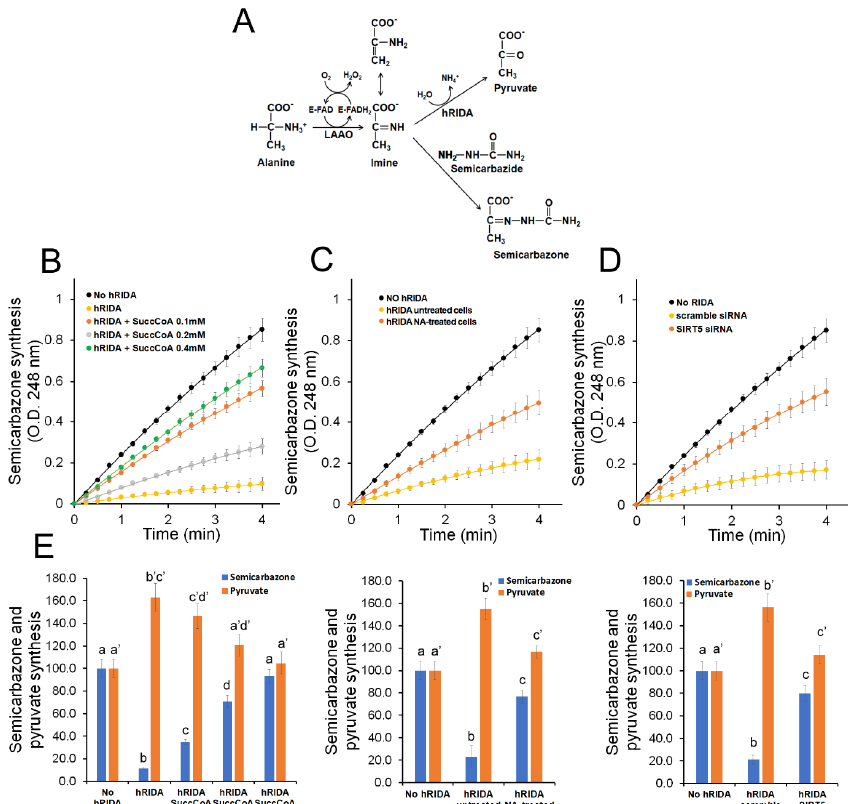
Figure 5. K-succinylation of hRIDA caused a strong reduction of hRIDA deaminase activity. ( A ) Reaction scheme of oxidative deamination of L-amino acids to the corresponding keto-acid catalyzed by the flavoprotein L-Amino Acid Oxidase (LAAO), through the formation of an unstable α -imino acid intermediate. The oxidative deamination of L-alanine generates the toxic compound 2-aminoacrylate (2AA) that tautomerizes to 2-iminopropionate (iminopyruvate), which is hydrolyzed to pyruvate and ammonia, spontaneously or enzymatically by hRIDA. The α -imino acid (iminopyruvate) intermediate reacts with semicarbazide to form the corresponding semicarbazone, which can be determined spectrophotometrically. ( B ) Time course of semicarbazone synthesis reactions carried out in the absence (no hRIDA) or in the presence of unmodified hRIDA (hRIDA) or hRIDA K-succinylated, with increasing concentration of succinyl-CoA (hRIDA + SuccCoA 0.1 mM, 0.2 mM, 0.4 mM). ( C ) Time course of semicarbazone synthesis reactions carried out in the absence (no hRIDA) or in the presence of hRIDA immunoprecipitated from untreated (hRIDA untreated cells) or nicotinamide (hRIDA NA-treated cells) cells. ( D ) Time course of semicarbazone synthesis reactions carried out in the absence (no hRIDA) or in the presence of hRIDA immunoprecipitated from scramble siRNA-transfected (scrambe siRNA) or from SIRT5 siRNA-transfected (SIRT5 siRNA) cells. ( E ) Semicarbazone and pyruvate synthesized in the hRIDA enzymatic assays as described in ( B – D ). Values are reported in histograms as percentage relative to the semicarbazone and pyruvate synthesized in the absence of hRIDA (No hRIDA). Values are means ± S.D. of three independent experiments. Within the same group, samples bearing different letters differ significantly ( p <